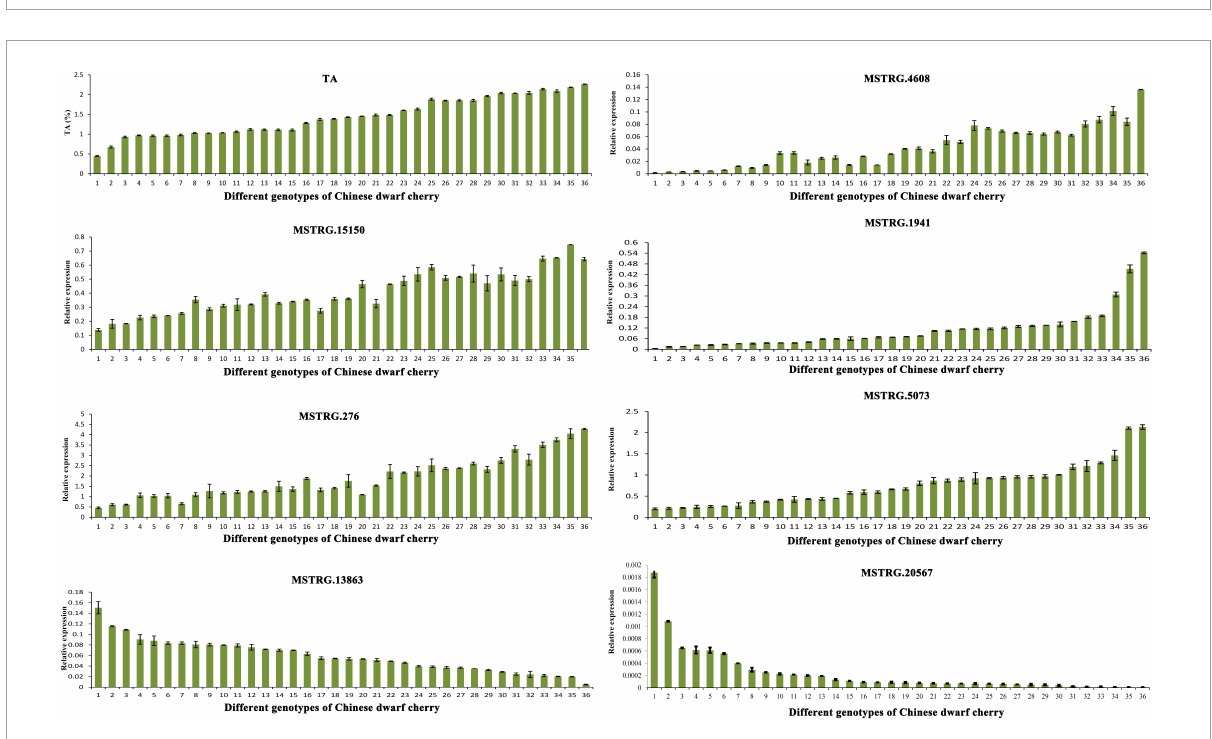
FIGURE9 Determination of TA content and qRT-PCR expression of key genes related to organic acid metabolism in fruits of 36 Chinese dwarf cherry genotypes. TA, titratable acid; qRT-PCR, quantitative reverse transcription-polymerase chain reaction.